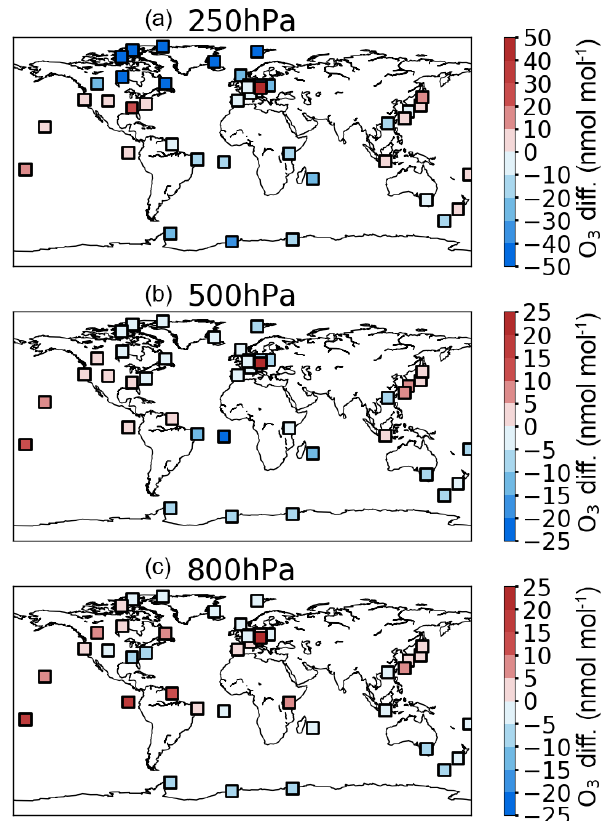
Figure 5. Annual mean bias of ECHAM-HAMMOZ with respect to ozonesonde data from Tilmes et al. (2012) at 250hPa (a) , 500hPa (b) , and 800hPa (c) . At 250hPa the relative error is shown for bet- ter visibility. Figure layout and scales are comparable to Lamarque et al. (2012).